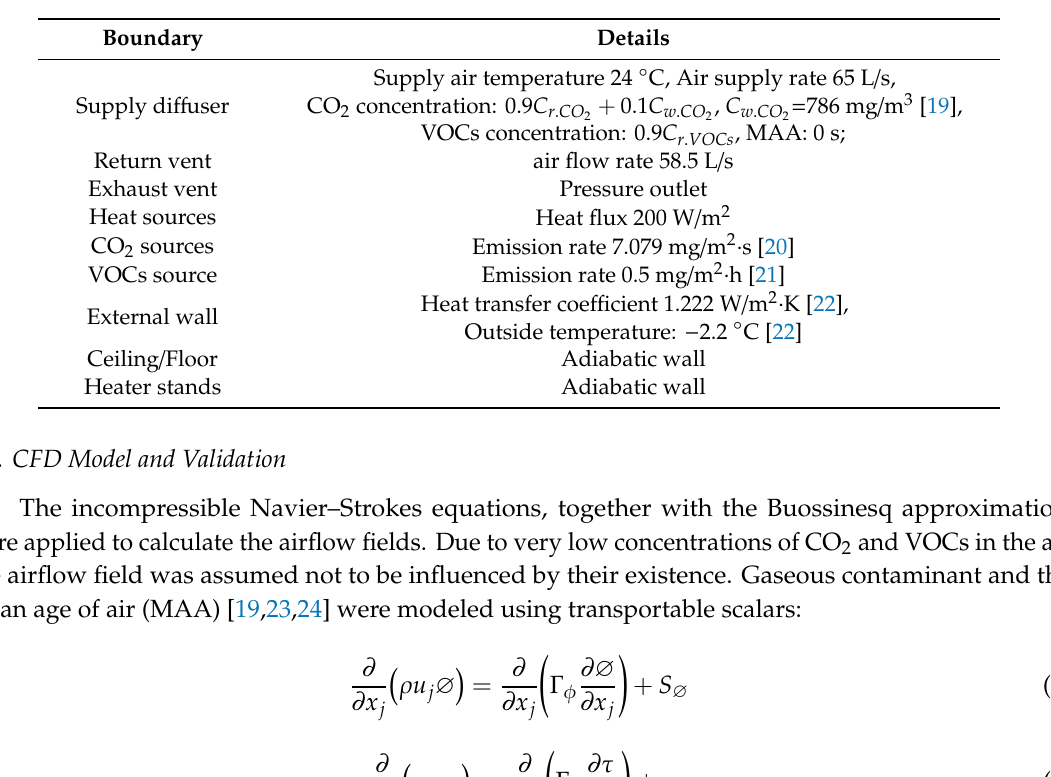
Table 1. Boundary conditions of